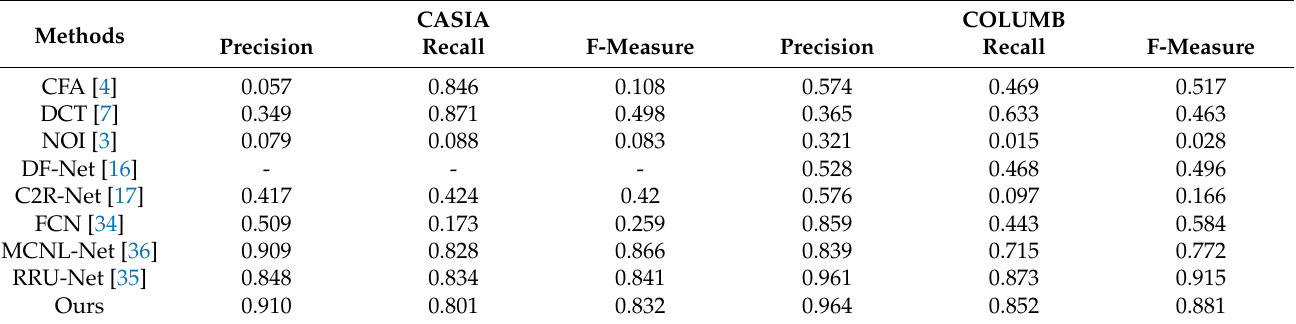
Table 4. Test results of common splicing